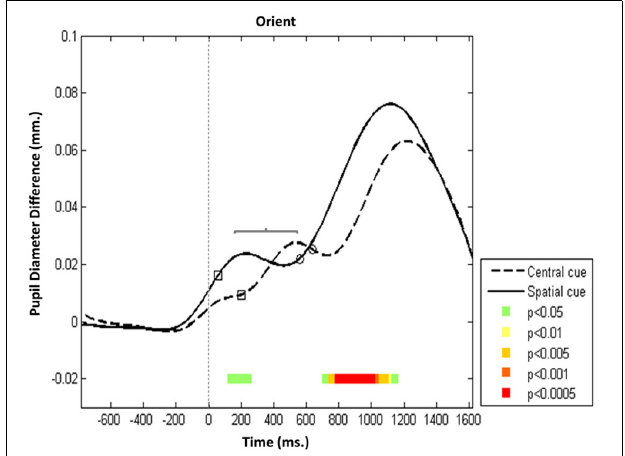
FIGURE 3 | Orienting network—Mean PD dilation. Blue line, central cue trials; black line, spatial cue trials; white squares, mean entrance to target AOI; white circles, mean response time. Time zero represents target onset (dashed gray line) and − 500ms cue onset (dotted gray line).